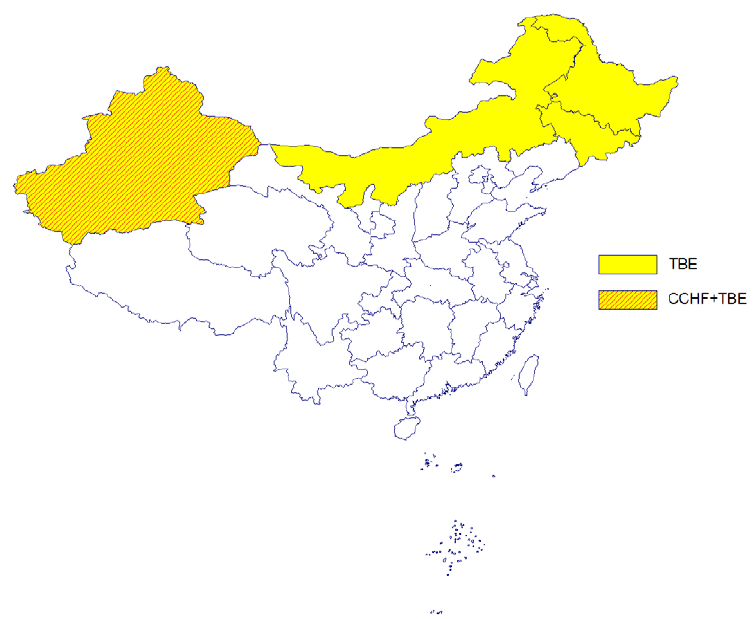
Figure 4. Distribution of tick-borne diseases in mainland China.